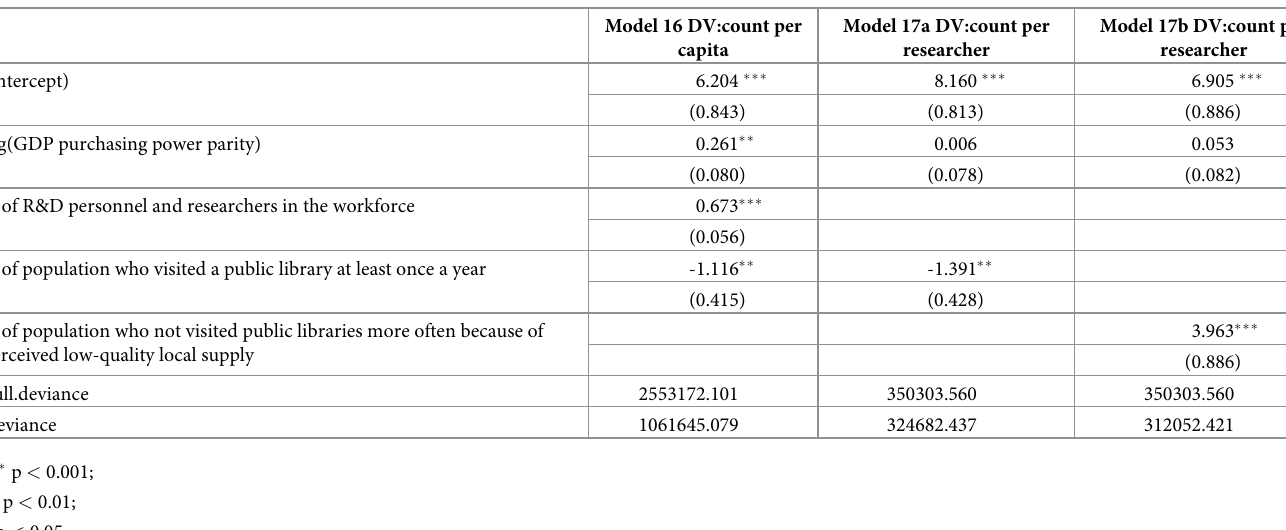
Table 10. European models IV: Eurobarometer variables (DVs: Download per capita, download per